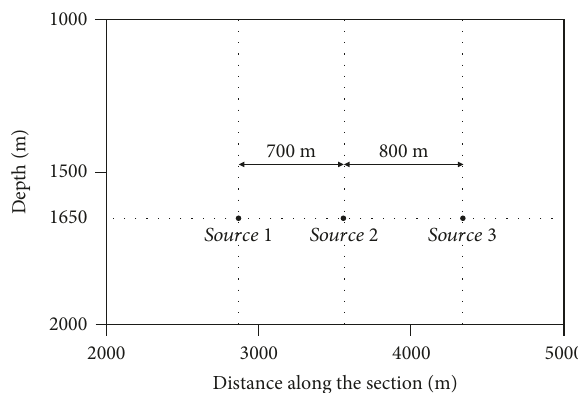
Figure 8: Illustration of the layout of the sources along the cross section in Figure